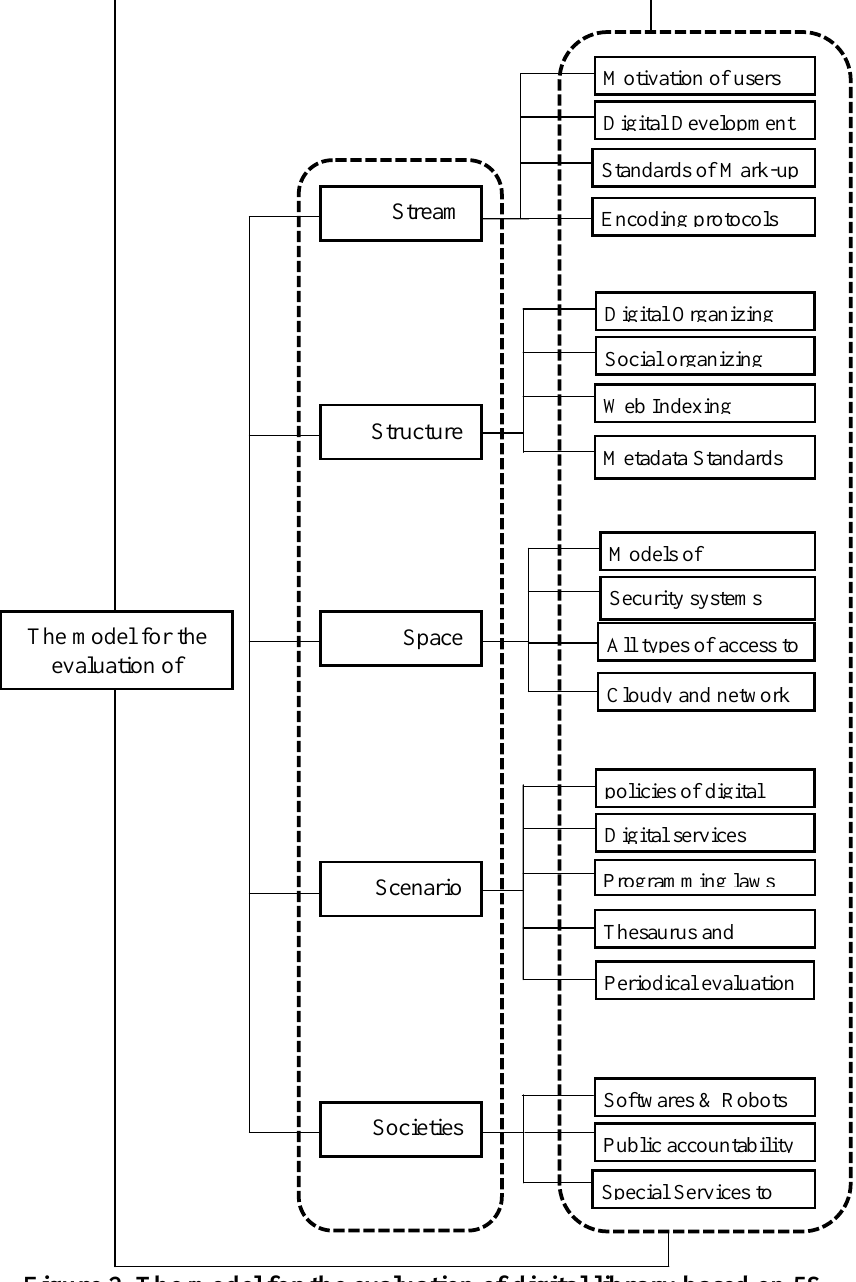
Figure 2. The model for the evaluation of digital library based on